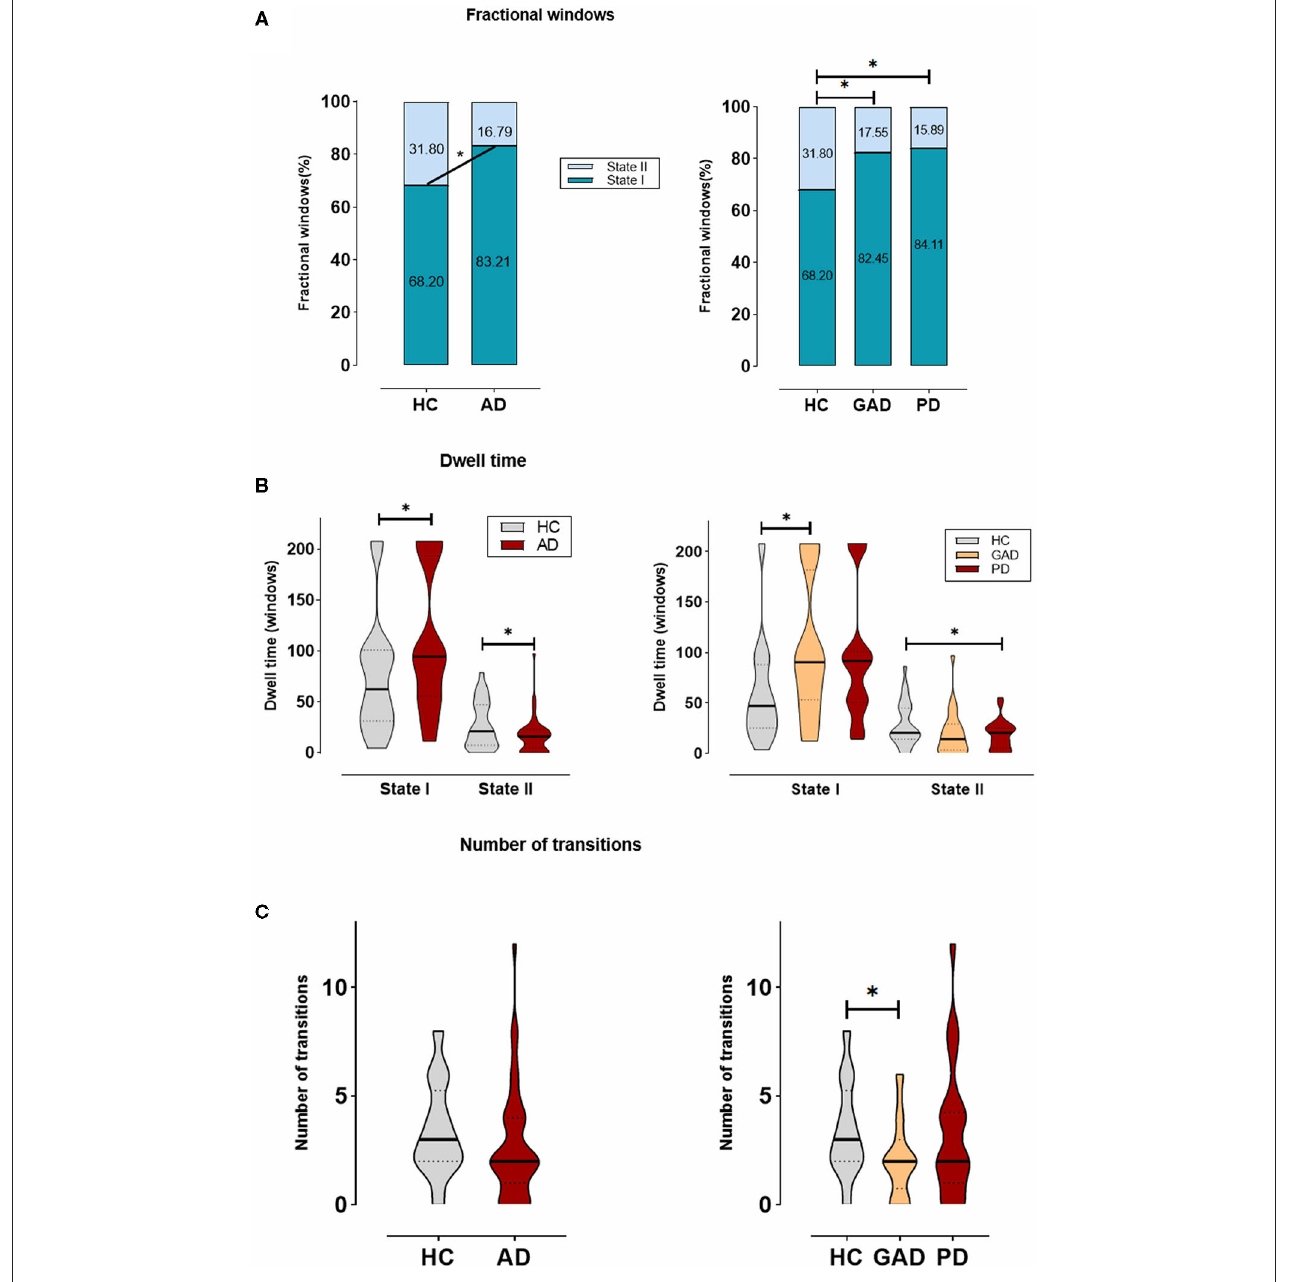
FIGURE 3 | The temporal properties of dynamic functional connectivity (DFC) states between AD and HCs, and also among generalized anxiety disorder (GAD), panic disorder (PD), and HCs. (A) The percentage of the mean fractional window subjects spent in each state. (B) Mean dwell time. (C) Number of transitions were depicted using violin plots. *Indicates that the difference between the two groups is statistically significant ( P <